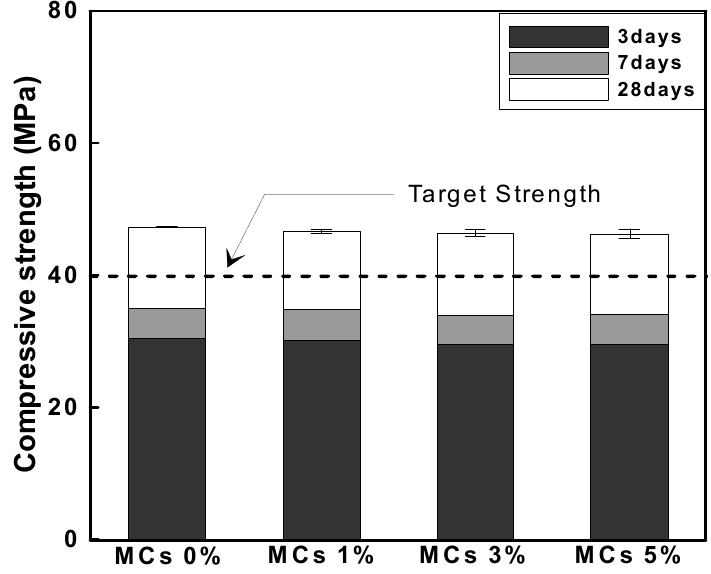
Figure 12. Evaluation result of compressive strength according to age.